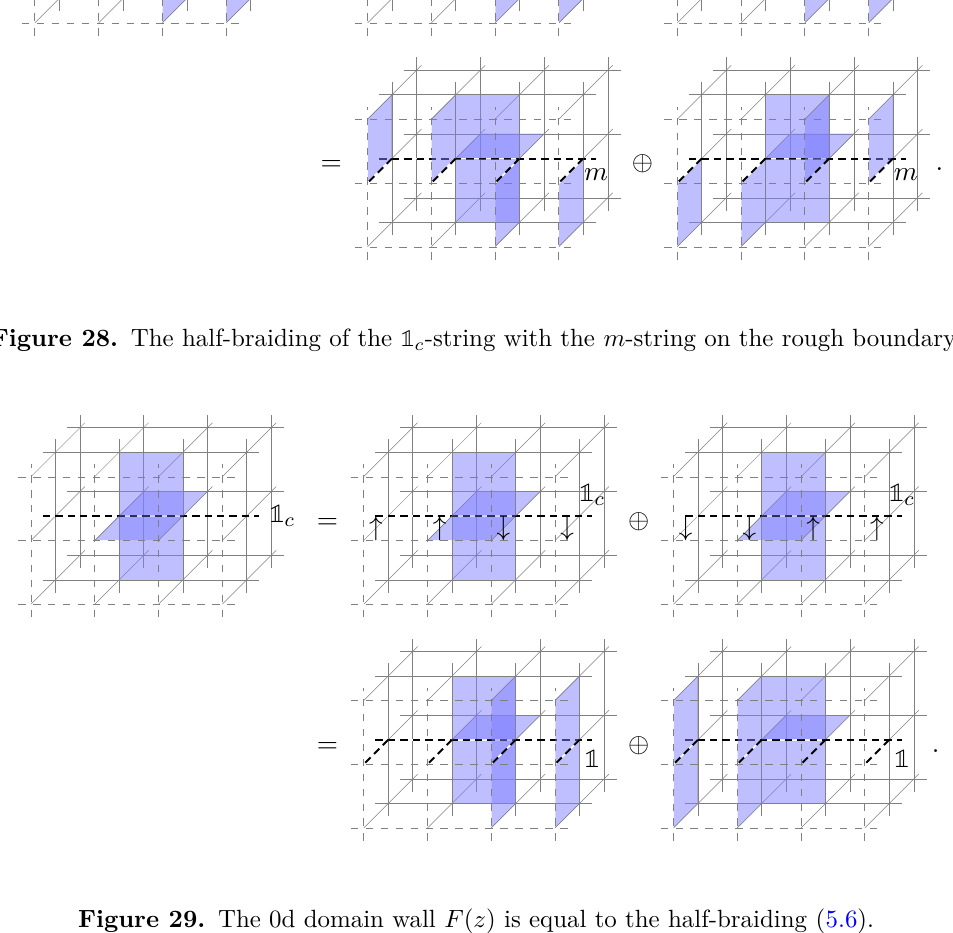
Figure 29. The 0d domain wall F ( z ) is equal to the half-braiding